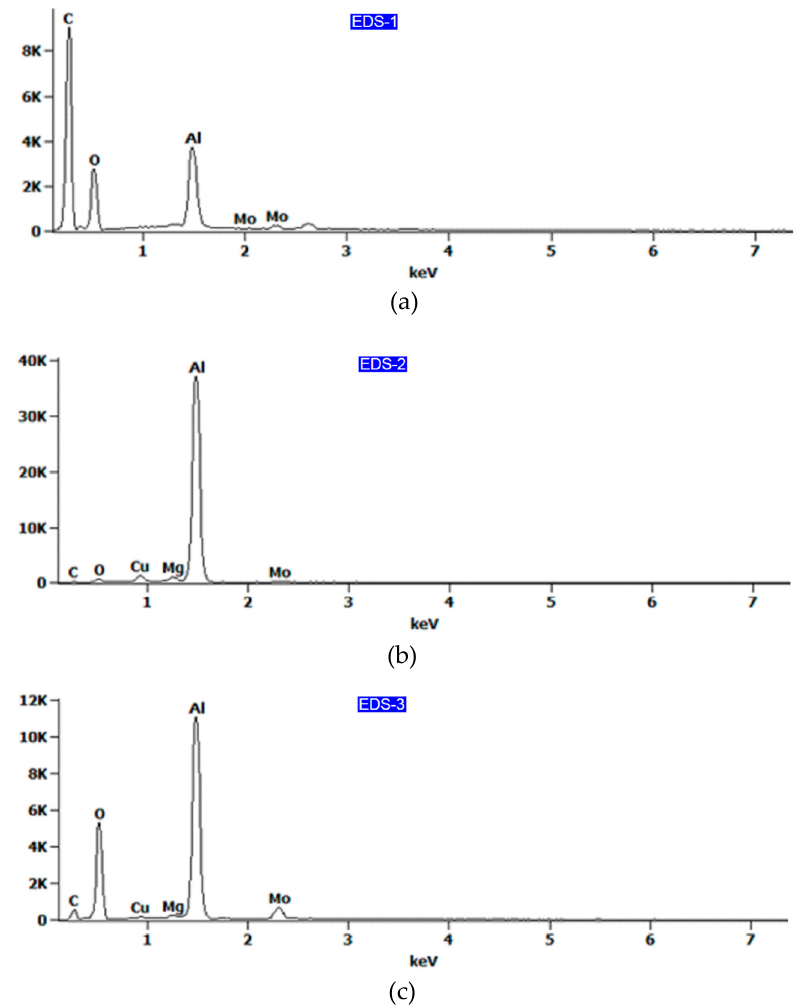
Figure 14. ( a ) Macrograph of the specimen tested at − 60 °C with both sides of the failure and ( b – e ) magnifications of the surface of the fracture.